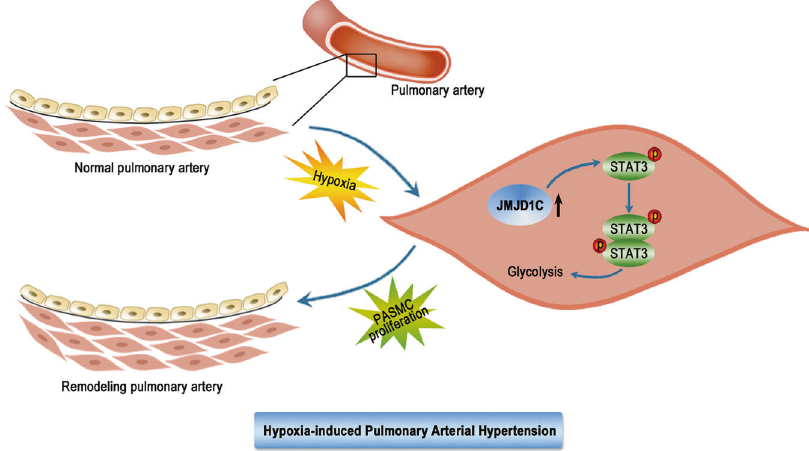
Fig. 8 Schematic illustration of the role of JMJD1C in hypoxia-induced PAH. PASMC Pulmonary arterial smooth muscle cell. Immuno fl uorescence staining Double immuno fl uorescence staining was performed to detect the expression of JMJD1C and Ki67 in pulmonary arteries. The paraf fi n- embedded slices were incubated with primary antibodies against JMJD1C (1:100; NBP1-77072, Novus Biologicals, Littleton, CO, USA), Ki67 (1:100; AF0198, Af fi nity, Changzhou, China), or α -SMA (1:200; BF9212, Af fi nity) overnight at 4 °C. Subsequently, the Cy3-conjugated goat anti-rabbit IgG antibody (1:200; A27039, Invitrogen, Carlsbad, CA, USA) or FITC-conjugated goat anti-mouse IgG antibody (1:200; Ab6785, Abcam, Cambridge, UK) was added and incubated for 90 min at room temperature.